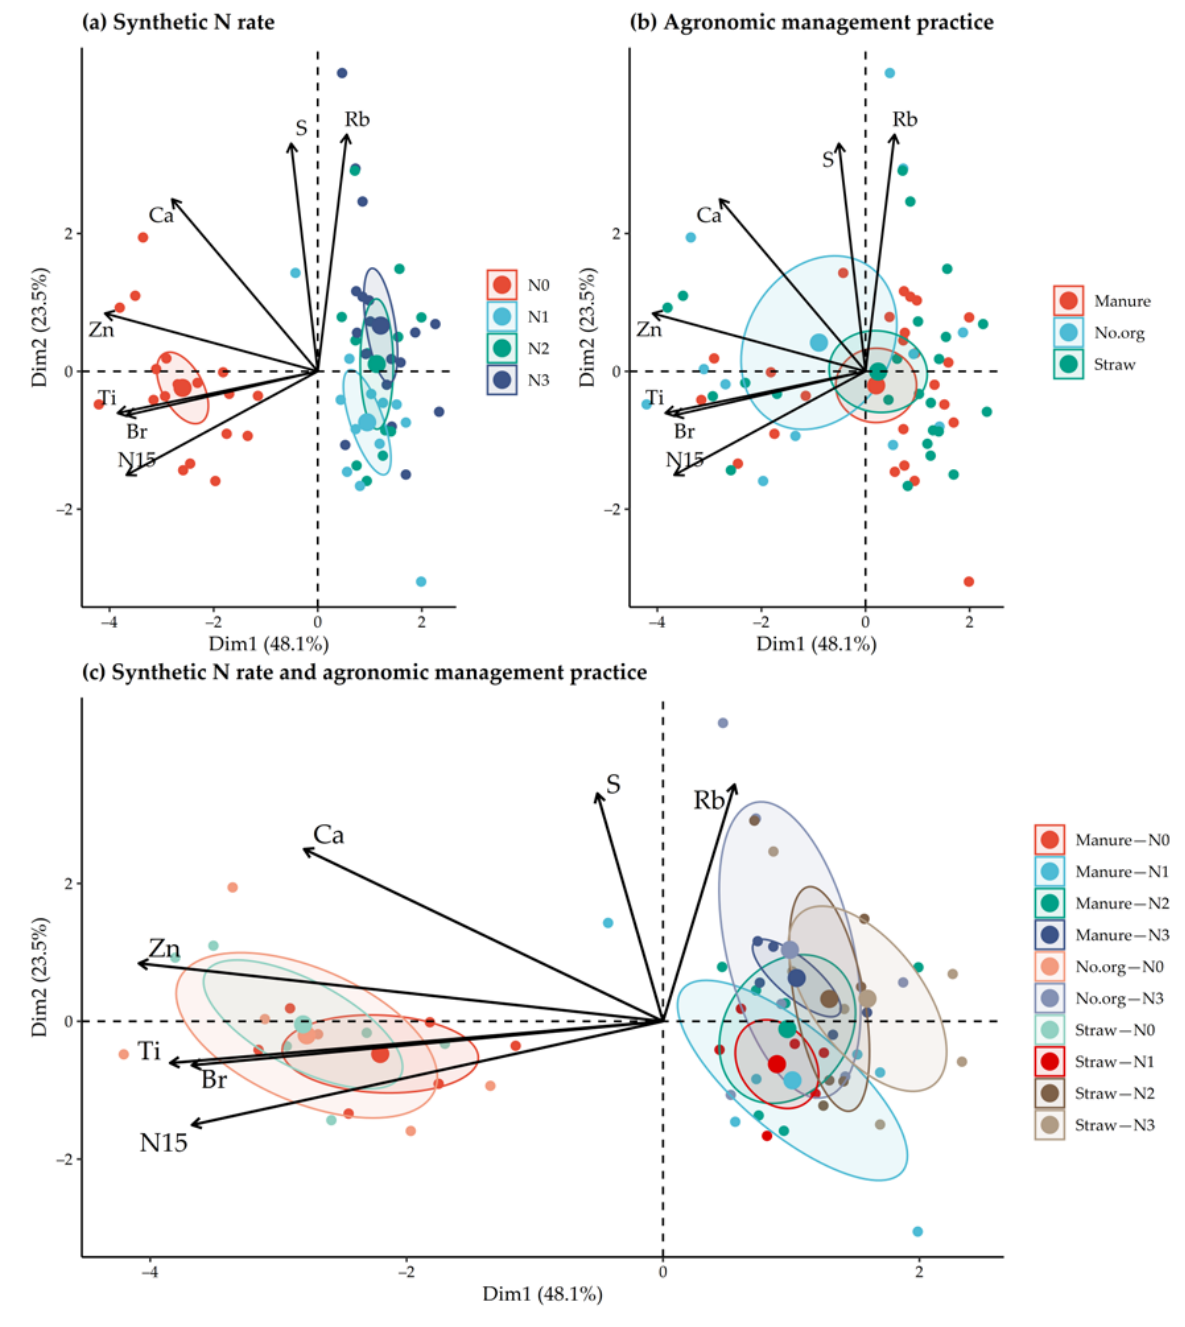
Figure 6. PCA analysis score plots ( a – c ) of macroelements (Ca, S), microelements (Ti, Zn, Rb, Br) and δ 15 N values in oat grains from 2016–2017 as a function of applied N rate and agronomic management practices of the long-term field experiment for the first and second principal components. The ellipses represent the mean and 95% confidence